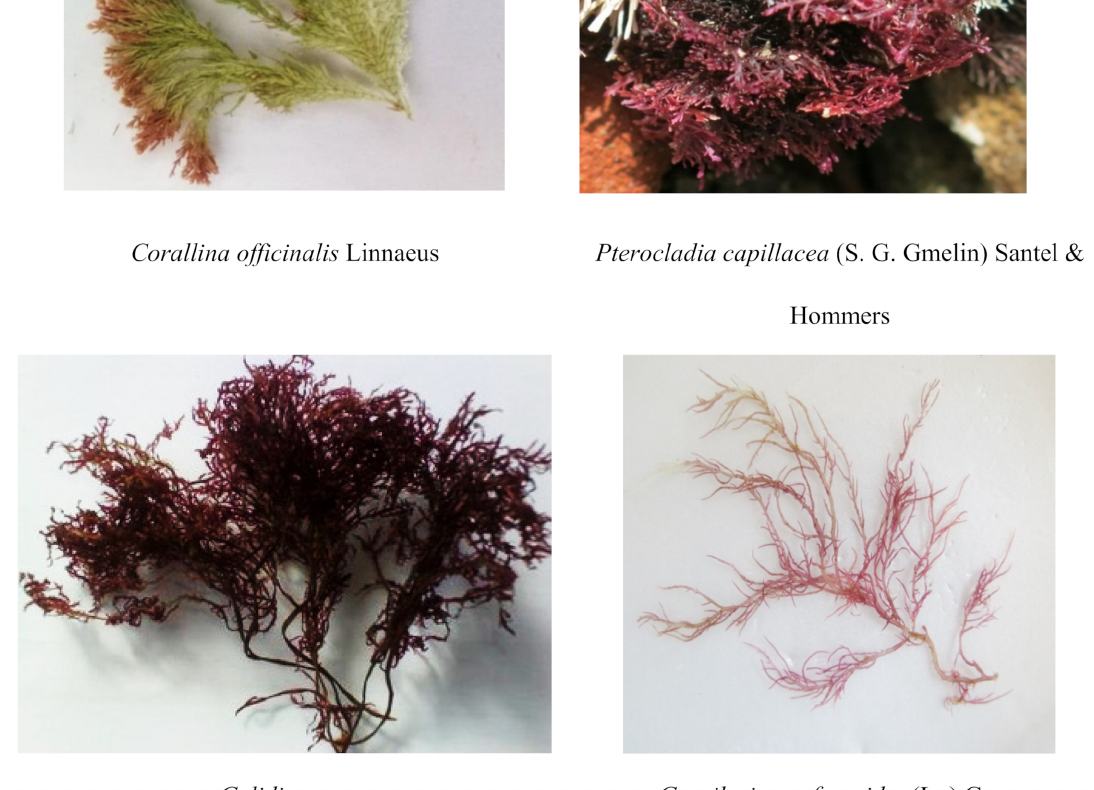
Figure 1. Photo of common red seaweed species with potential from Egypt